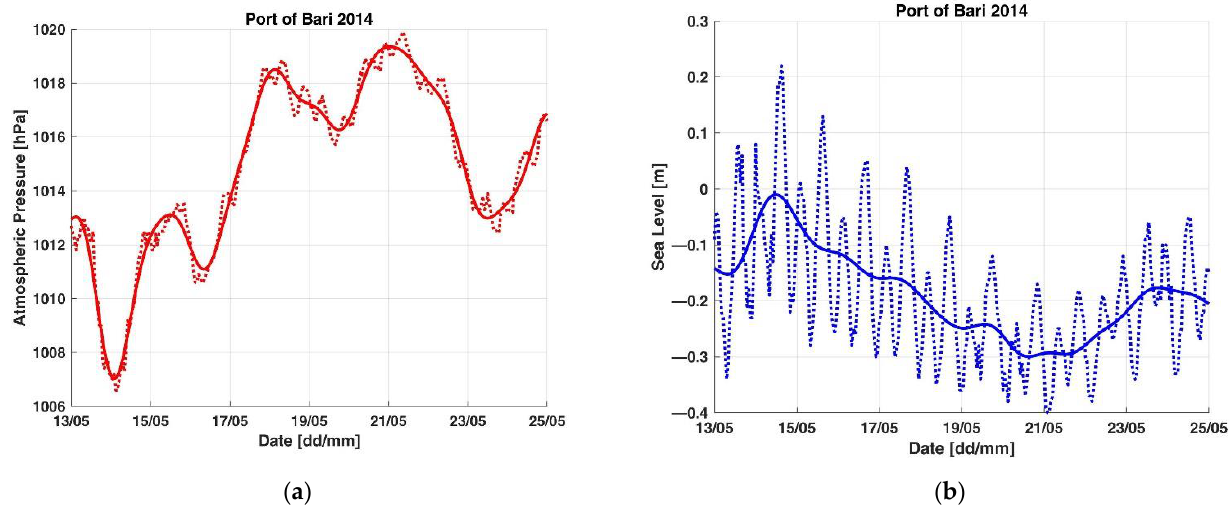
Figure A16. Low-frequency components of meteo- mareographic parameters acquired by ISPRA’s monitoring station in the port of Bari from 13 to 25 May 2014: ( a ) atmospheric pressure; ( b ) sea level.